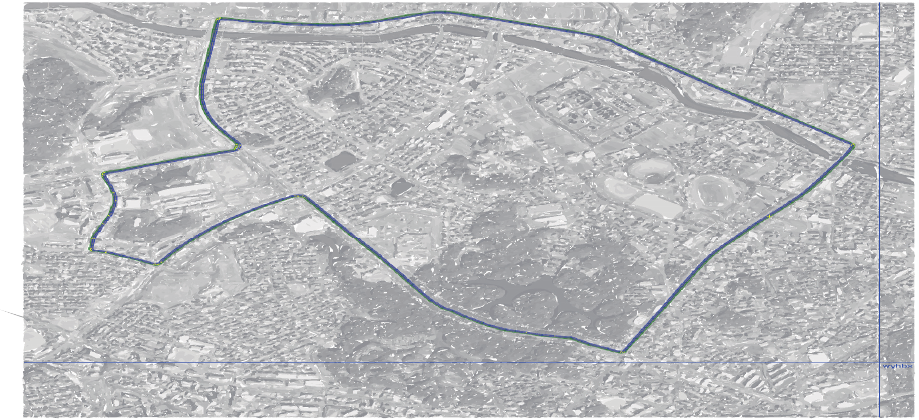
Figure 11. (Scenario-2) A city road scenario (geographical data from OSM [36] are illustrated as superimposed background